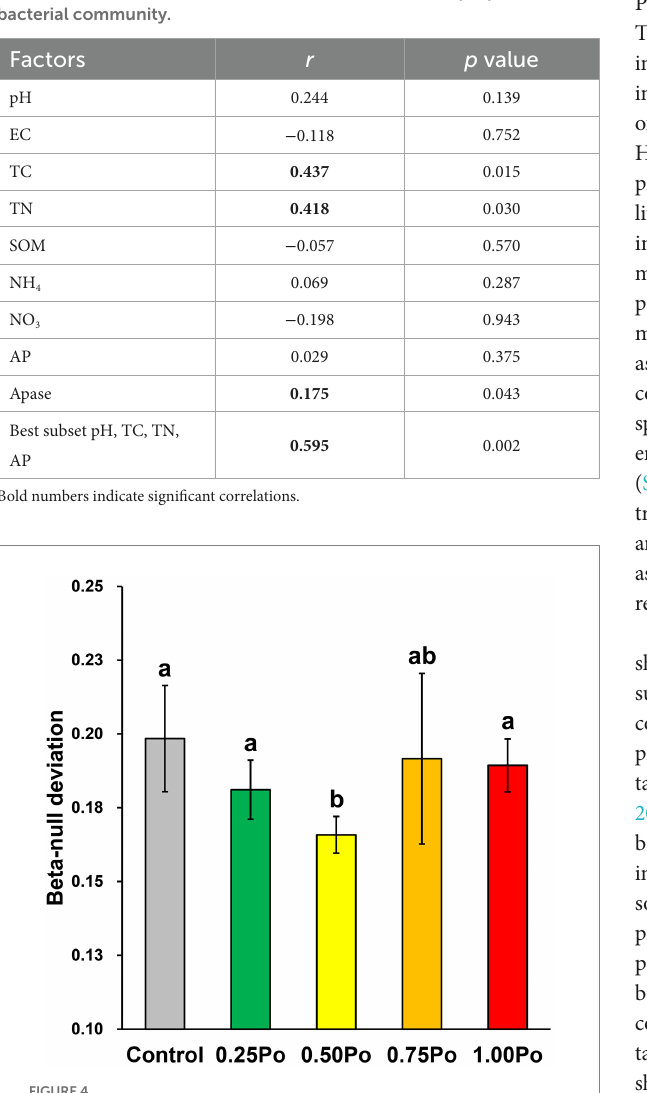
FIGURE 4 Beta-null deviations of the bacterial community under different treatments. Bars with different letters (shown above each) are significantly different ( p < 0.05) as revealed by the Kruskal–Wallis rank- sum